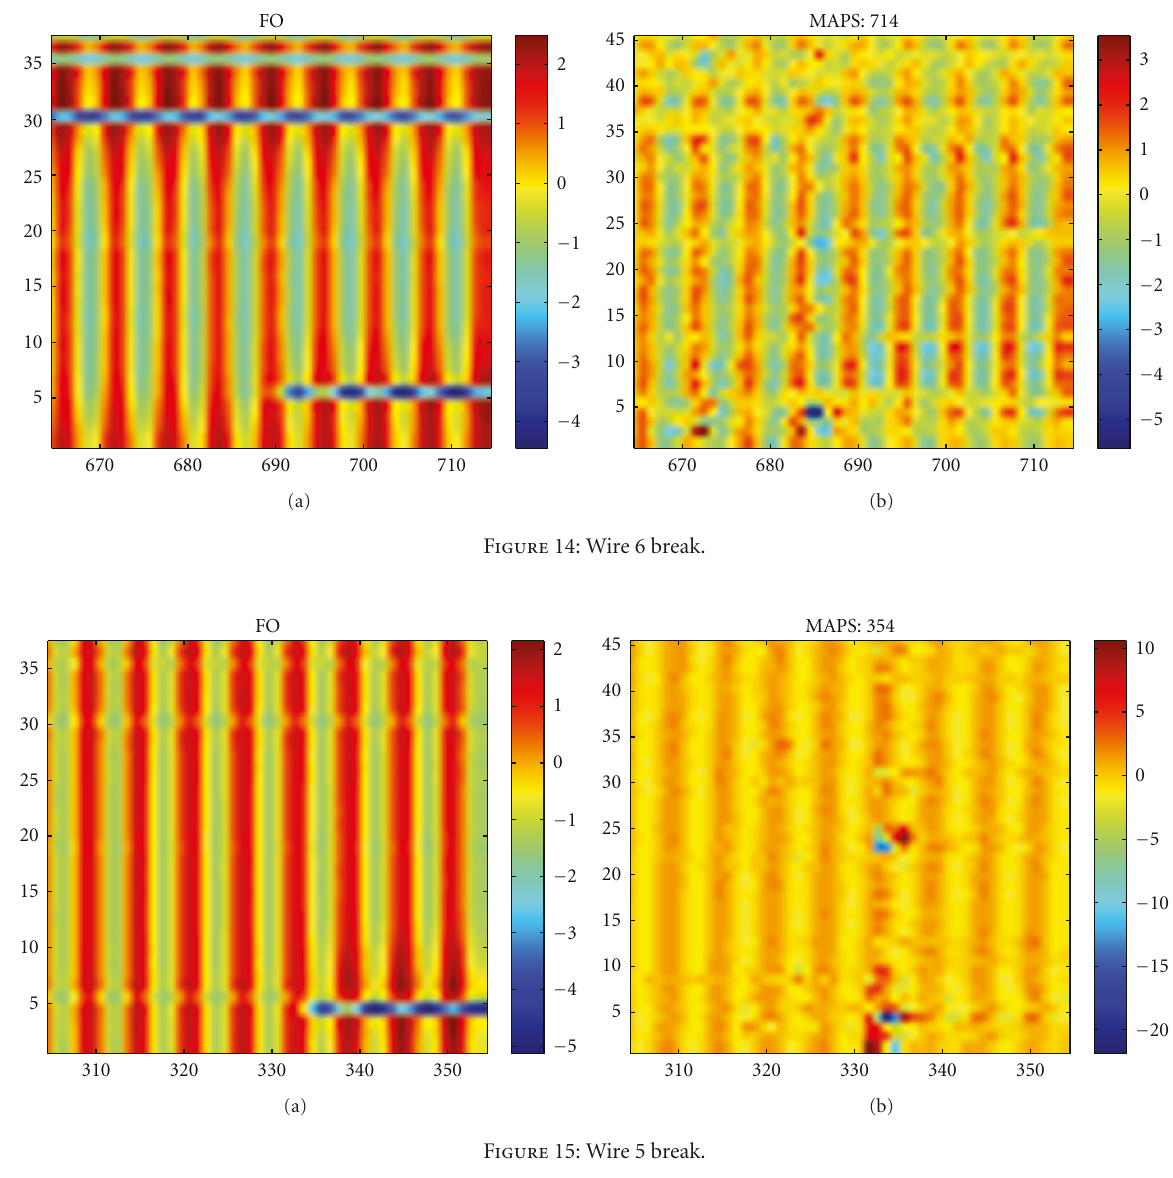
Figure 15: Wire 5